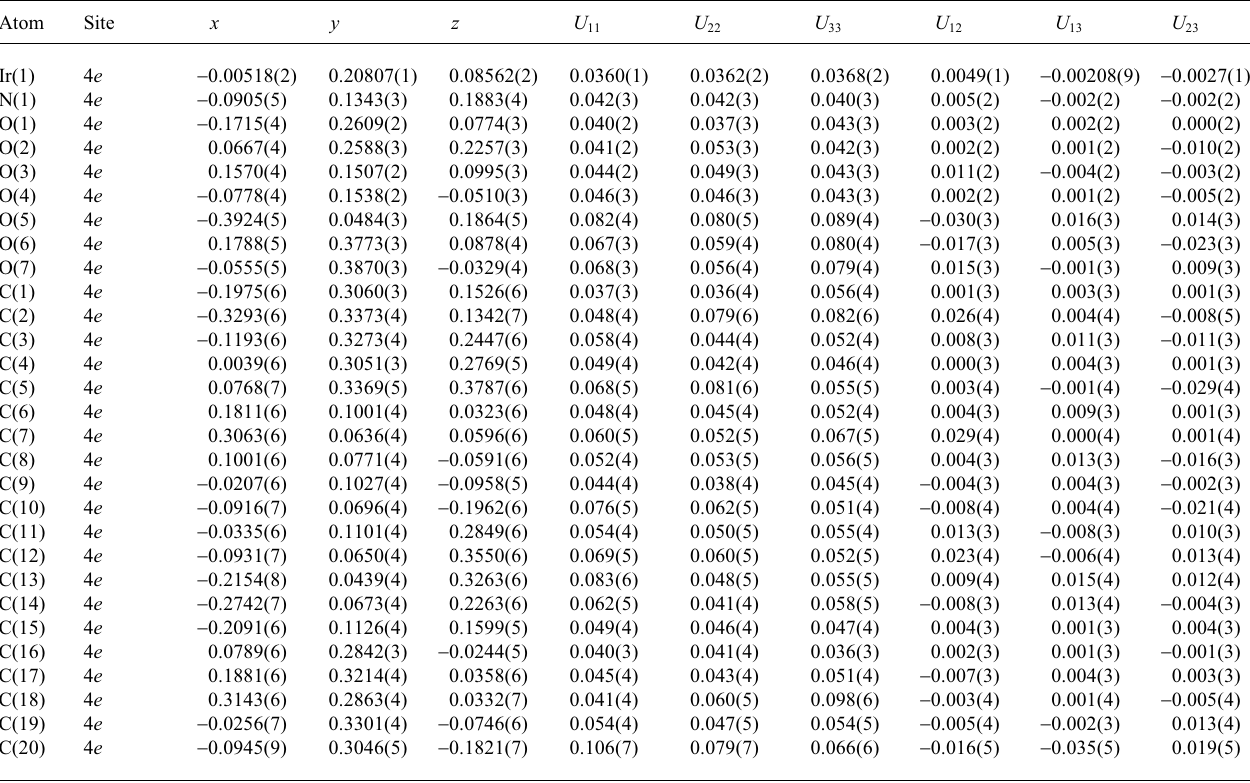
Table 3. Atomic coordinates and displacement parameters (in Å 2